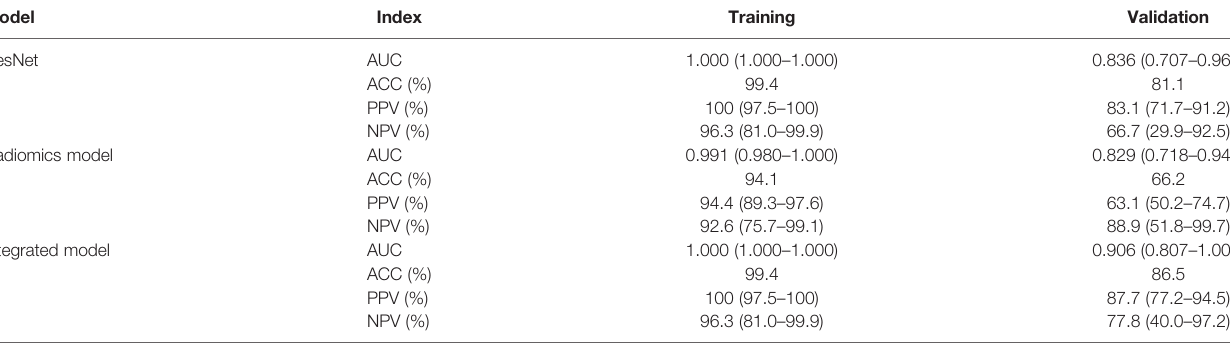
TABLE 2 | Summary of the performance of the CNN, radiomics, and integrated models in predicting the mutation status of PTEN in the training and validation datasets. Model